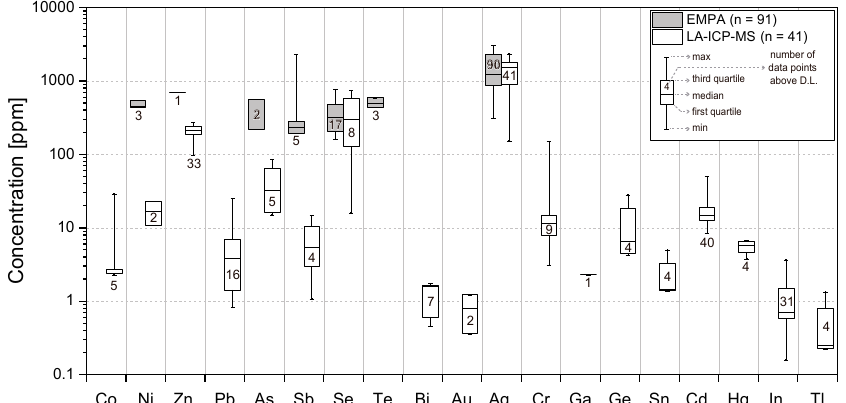
Figure 3. Boxplot of EMPA and LA-ICP-MS data for selected minor and trace elements in chalcopyrite from the Cerro Pabellón geothermal system. Analyses are plotted in parts per million (ppm) on a vertical logarithmic scale. The maximum, median, and minimum concentrations are indicated, as well as the number of analyses above the detection limit for each element (displayed inside or below the boxes). Analyses with “spiky profiles” in Table S2, attributed to inclusions, were not plotted.